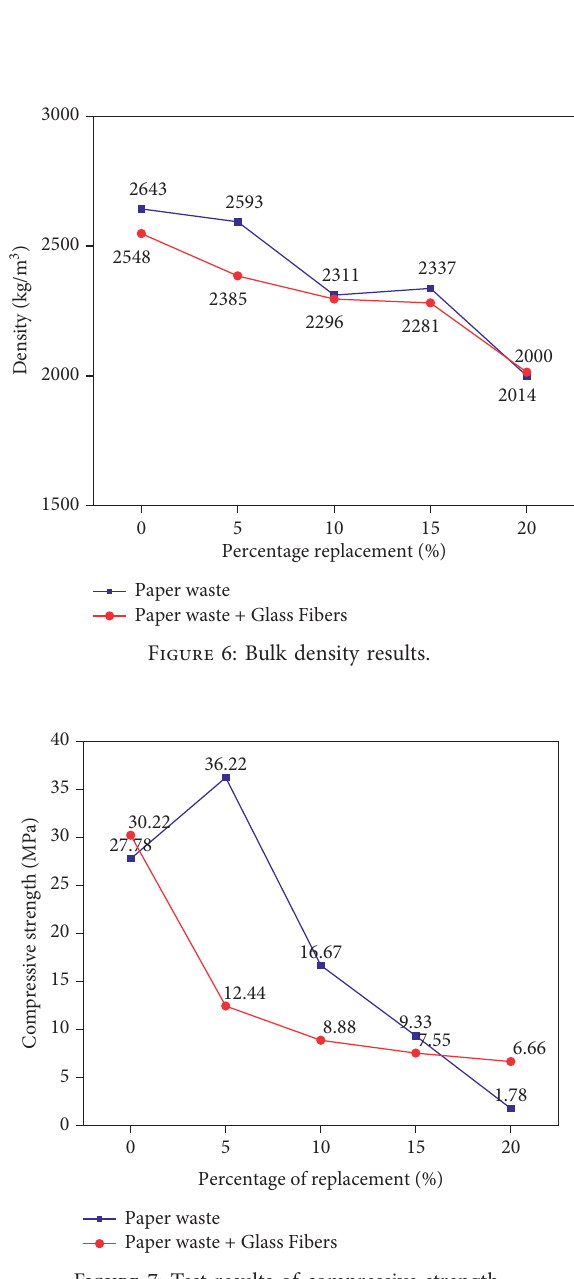
Figure 7: Test results of compressive strength.